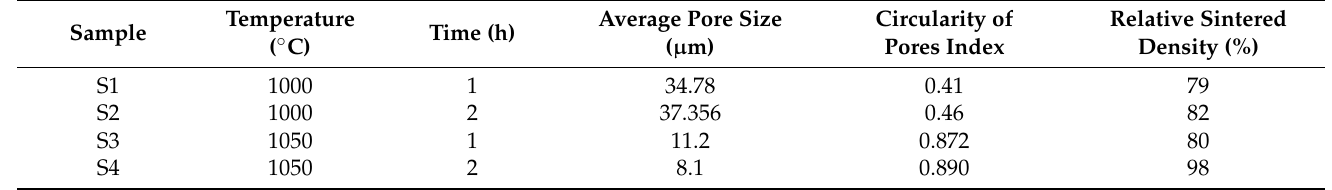
Table 3. Pore size and morphology of the as-sintered HEA NiMnFeCu under various conditions. Sample